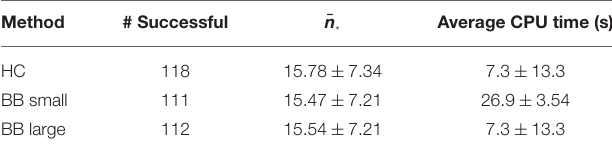
TABLE 5 | Results of BB-Schedule in comparison to HC-Schedule.